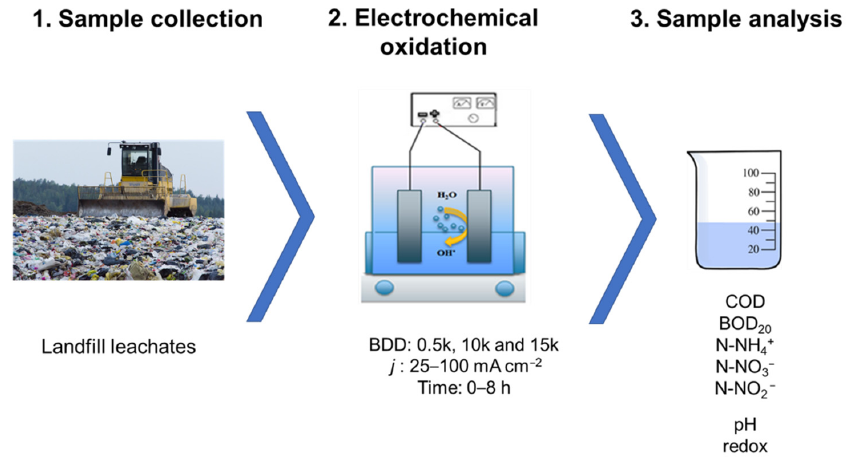
Figure 1. Procedure scheme.